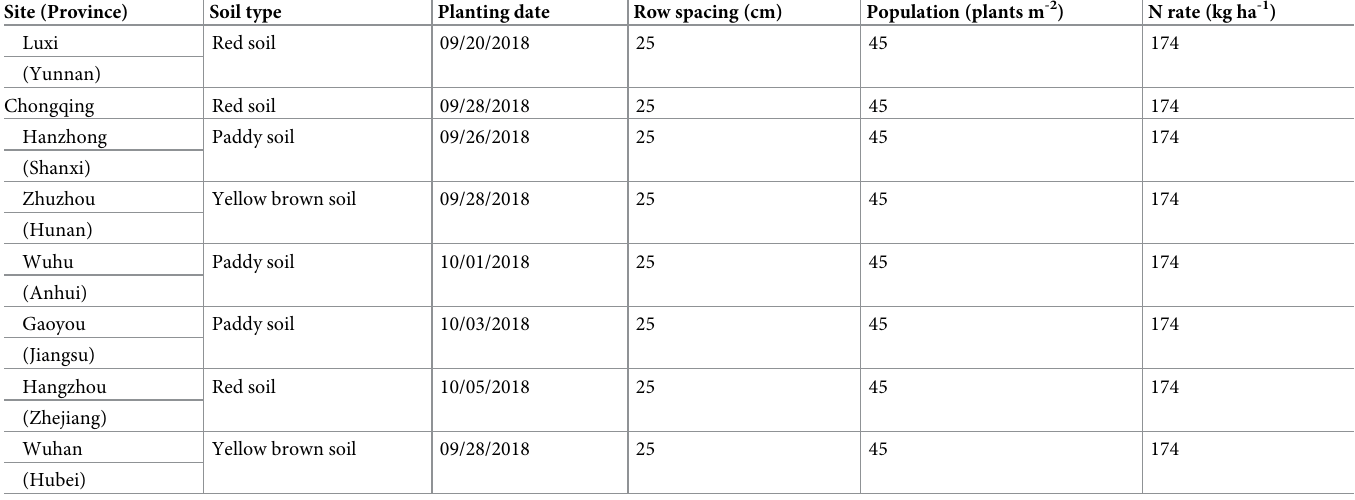
Table 2. Management practices at eight